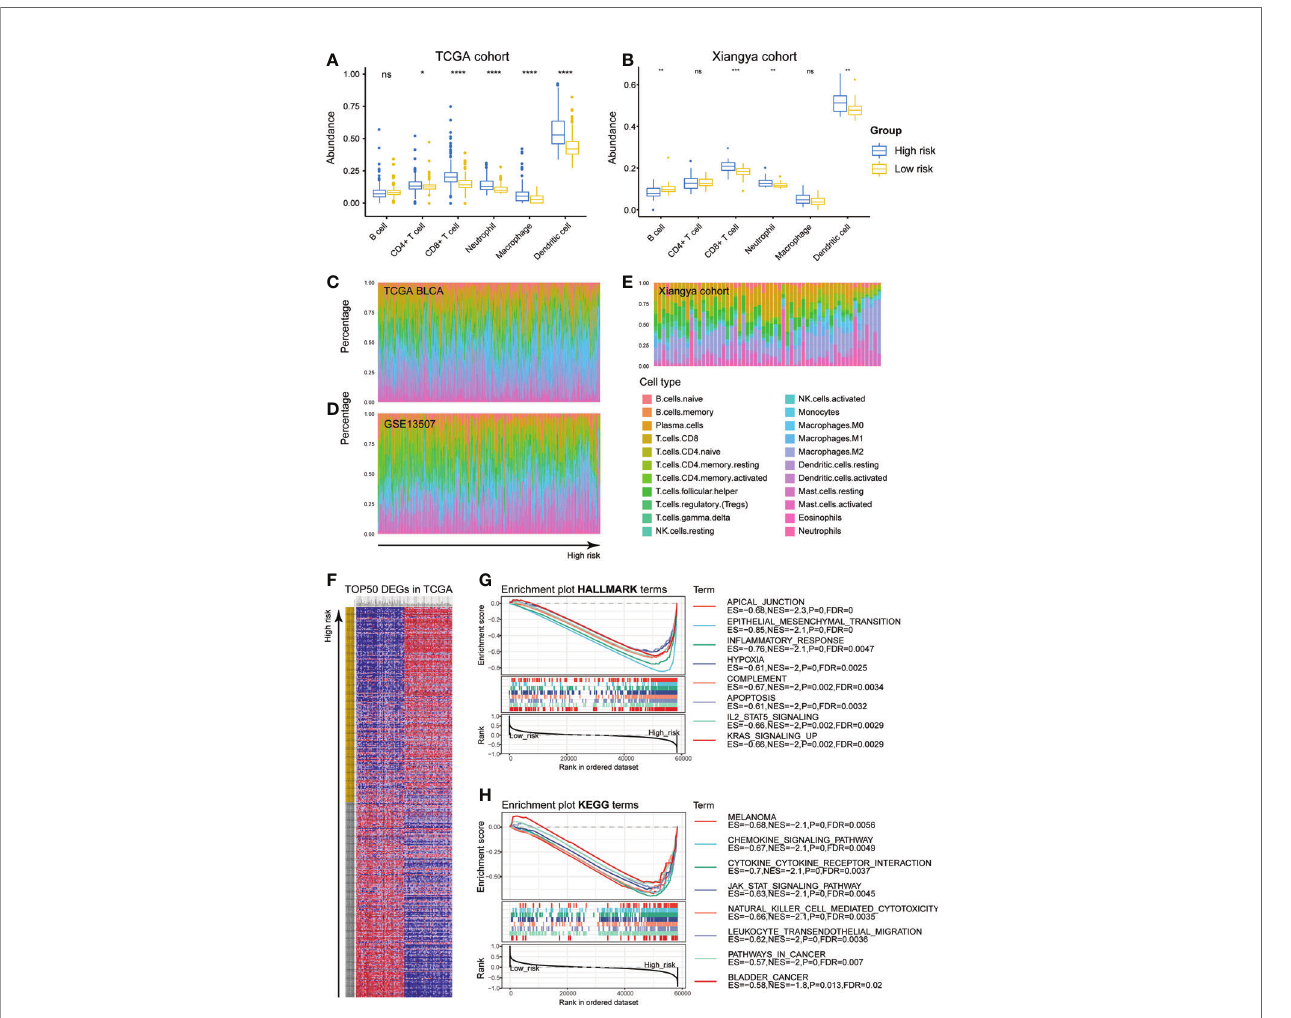
FIGURE 8 | High-risk samples sharing higher abundance of immune in fi ltrates, tumor hallmarks, and immune-oncologic terms. (A, B) The abundance of 6 immune in fi ltrates between high- and low-risk groups in TCGA BLCA and Xiangya cohorts (based on TIMER algorithm). (C – E) The abundance of 22 immune in fi ltrates in TCGA BLCA, GSE13507 and Xiangya cohorts (based on CIBERSORT algorithm). (F) TOP 50 positive and negative DEGs between high- and low-risk groups in bladder cancer. (G, H) Enriched HALLMARK and KEGG terms for high-risk gene set. *P < .05, **P < .01, ***P < .001, ****P < .0001. ns, not signi fi cant.